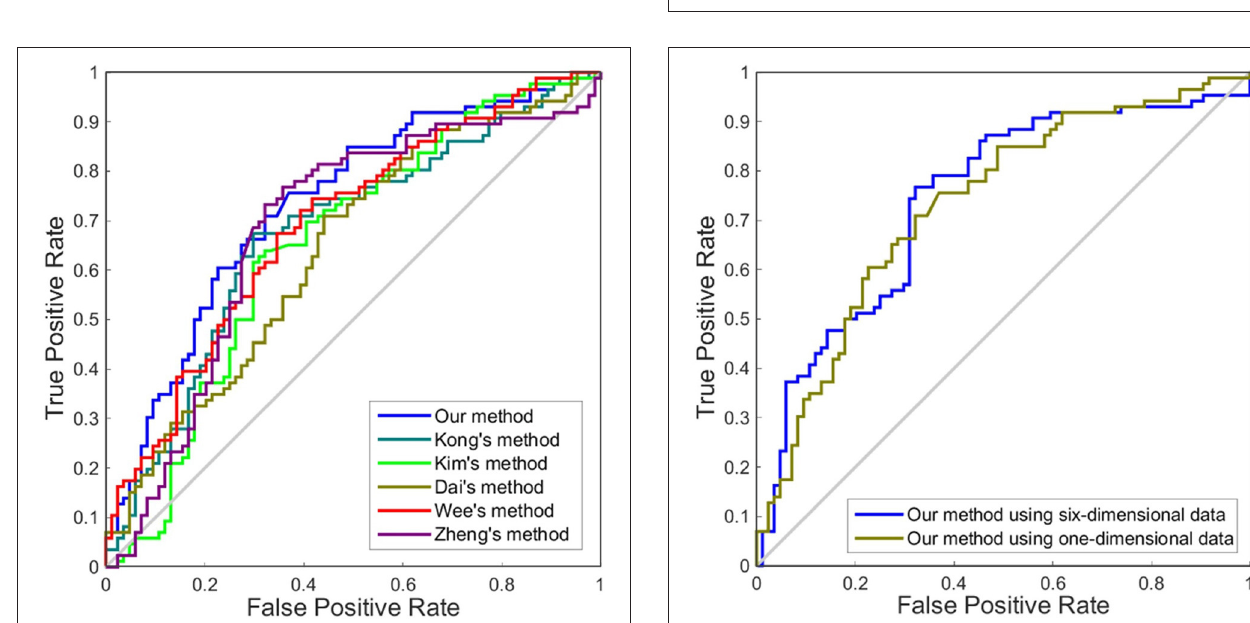
FIGURE 6 | ROC curves of our method using different dimensions of original features to distinguish MCI and NC. The different line colors represent ROC curves of our methods of constructing individual morphological brain networks based on different dimensional features. ROC, receiver operating characteristic.